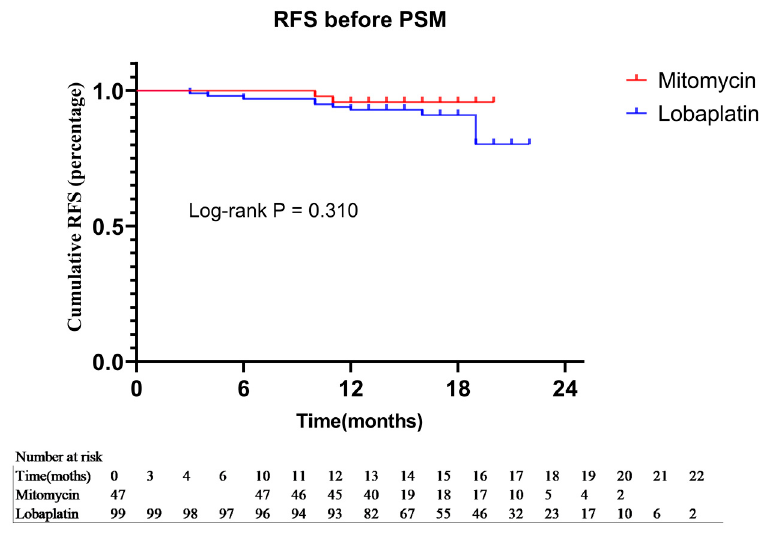
Figure 3. Kaplan-Meier method was used to recurrence-free survival between the Mitomycin group and Lobaplatin group before PSM.